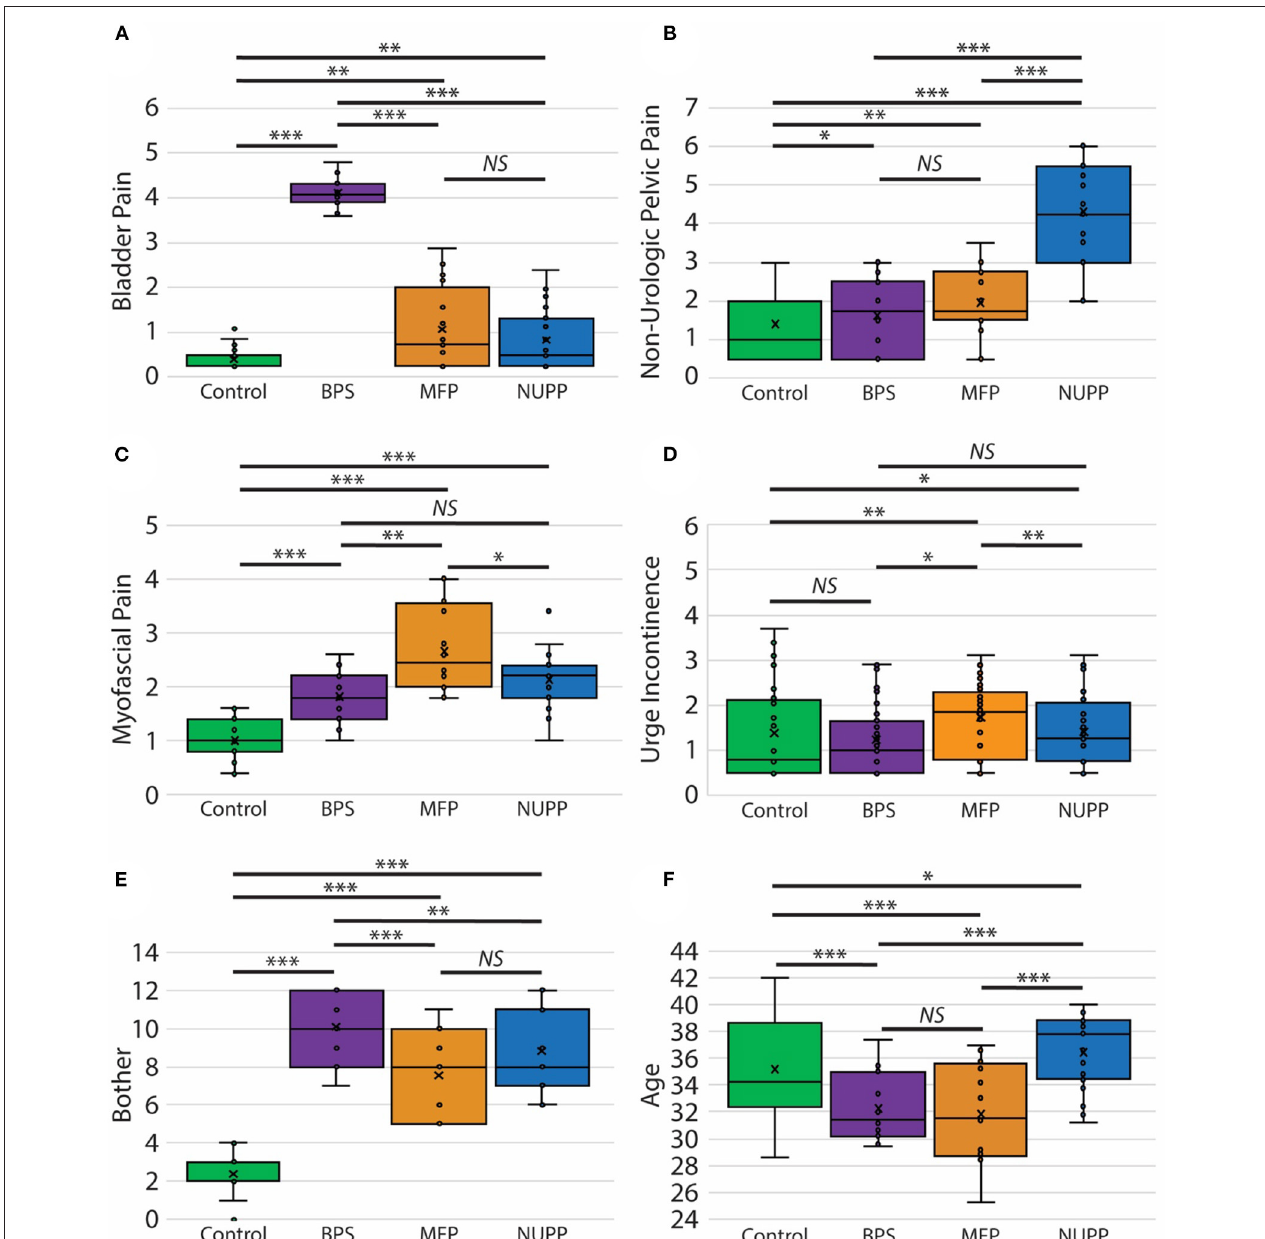
FIGURE 5 | Clinical features of pelvic pain patients identified by unsupervised clustering. Measures of the phenotypic characteristics of the presumptive IC/BPS clusters are plotted as box and whisker plots. Subjects exhibited distinct associated pain symptoms. The BPS group (purple) was homogenously high for bladder pain related to bladder filling (A) , while the NUPP group (blue) demonstrated pelvic pain focused on the urethra and vagina unrelated to urination (B) . The MFP group (orange) had features of myofascial pain (C) . None of these groups exhibited significant urgency incontinence (D) and were all significantly bothered by their symptoms in comparison to controls (E) . The BPS and MFP groups were significantly younger than controls or NUPP patients (F) . *** p < 0.0001, ** p < 0.005, and * p < 0.05.